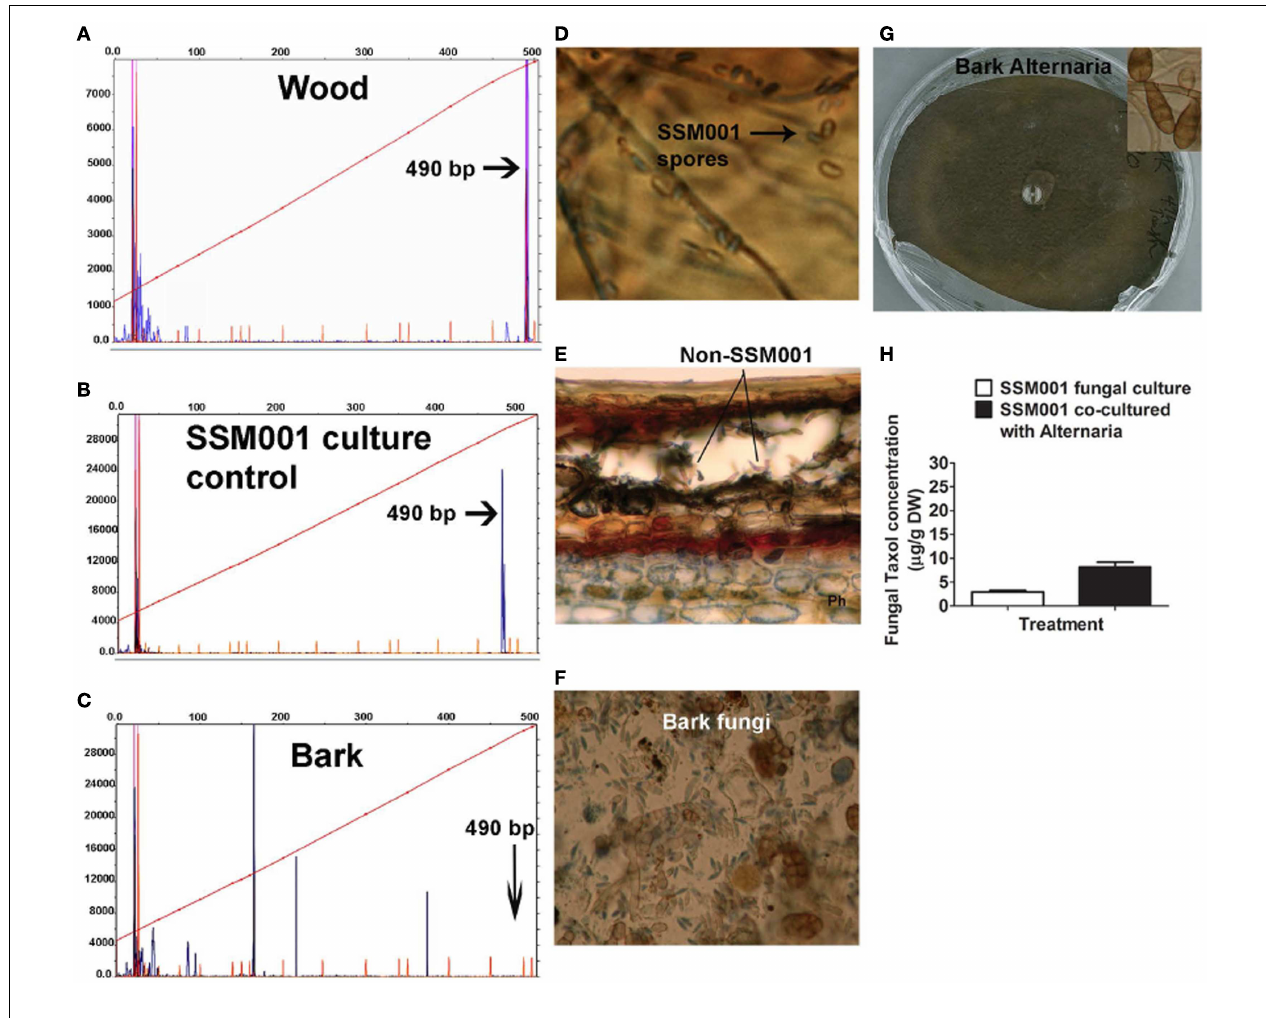
fingerprinting (fungal 18S tRFLP) of Taxus outer bark.The dendrogram shows five novel peaks (blue) other than SSM001. (D) SSM001 spores. (E) Non-SSM001 fungal spores in the outer bark in a transverse section of a Taxus branch. (F) Close-up of spores from Taxus outer bark, stained with Trypan blue, showing the diversity of fungi. (G) Isolation and culturing of pure Alternaria fungus from the outer bark of T. x media . (H) Effect of co-culturing of pure Alternaria fungus with SSM001 in liquid